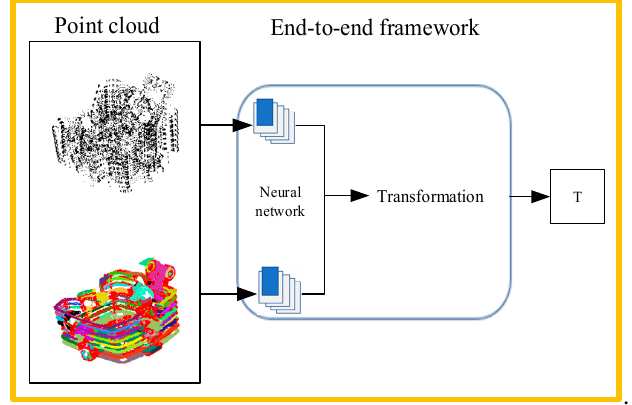
Figure 18. Learning-based point cloud registration algorithm.